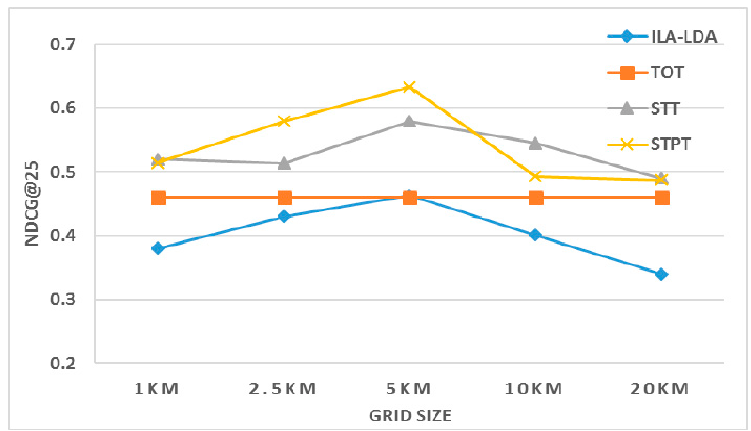
Figure 10. The NDCG values of recommendation models for different grid sizes.